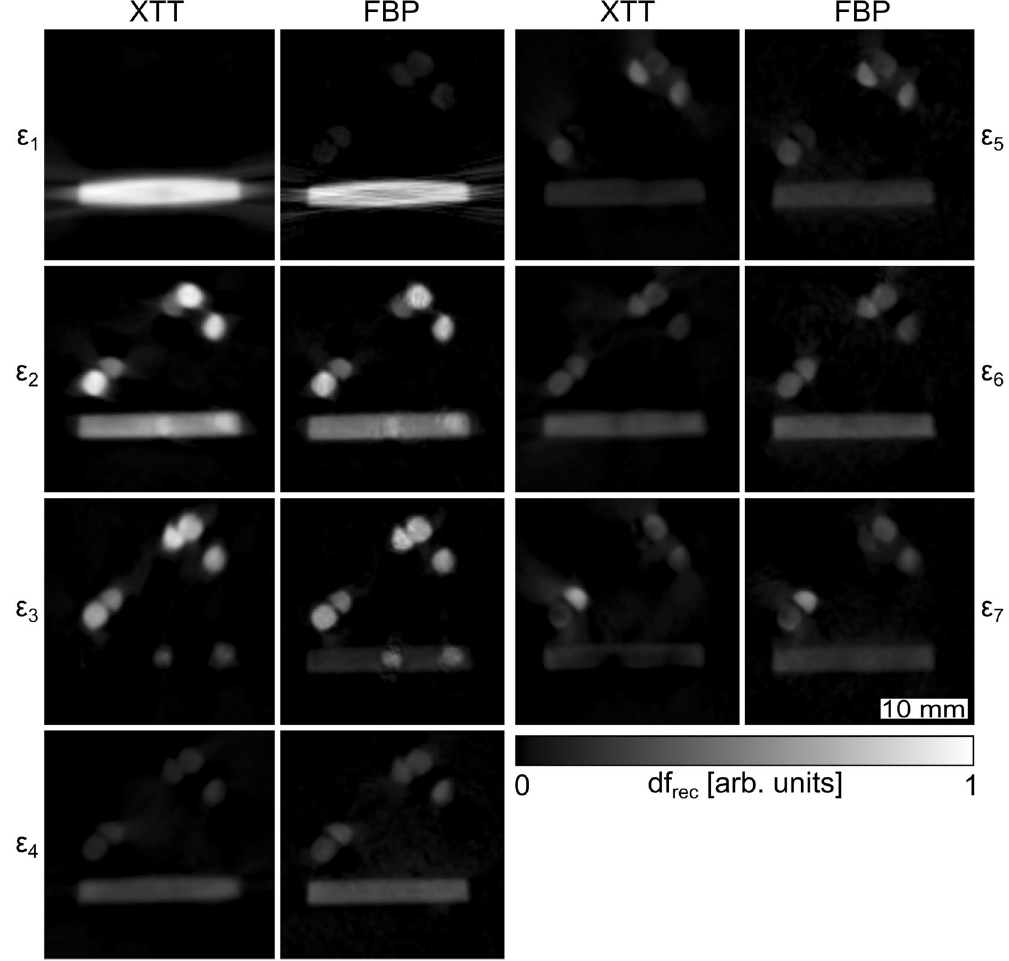
Figure 5. Comparison of scattering components reconstructed with XTT and direct FBP based measurement. The same scattering components ε k were reconstructed with both methods and are shown for a single slice. The columns labelled XTT and FBP show the results from an XTT reconstruction and the results directly measured with horizontal gratings and reconstructed using FBP, respectively. The greyscale for all images is the same. An animation of the figure that shows all slices can be found in the supplementary